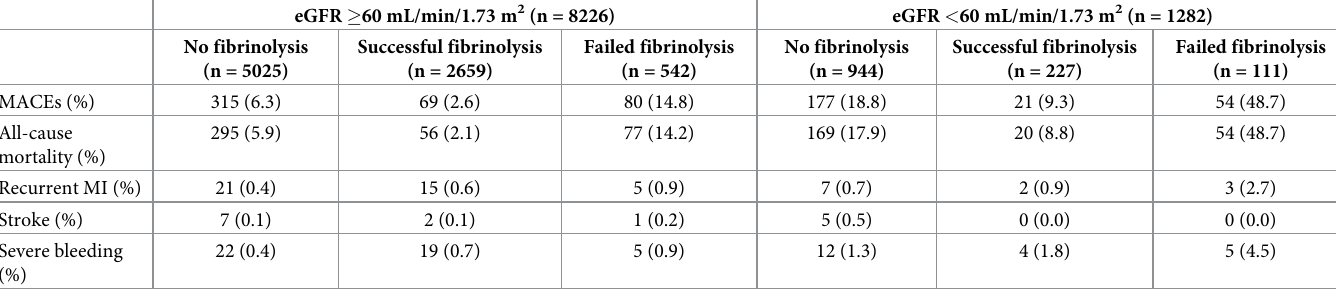
Table 3. Crude incidence rates of short-term outcomes by no, failed, and successful fibrinolysis, among patients with and without reduced kidney function (eGFR < 60 mL/min/1.73 m 2